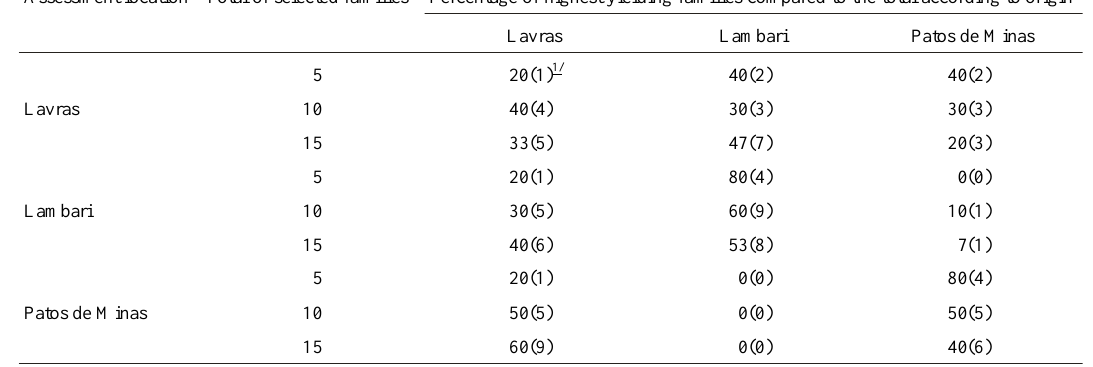
Table V - Num ber and per cent age of the fam i lies from each or i gin among the 5, 10 or 15 high est and low est yield ing fam i lies when as sessed in Lavras, Lambari e Patos de Minas. As sess ment lo ca tion To tal of se lected fam i lies Per cent age of high est yield ing fam i lies com pared to the to tal ac cord ing to or i gin Lavras Lambari Patos de Minas 20(1) 1/ Lavras